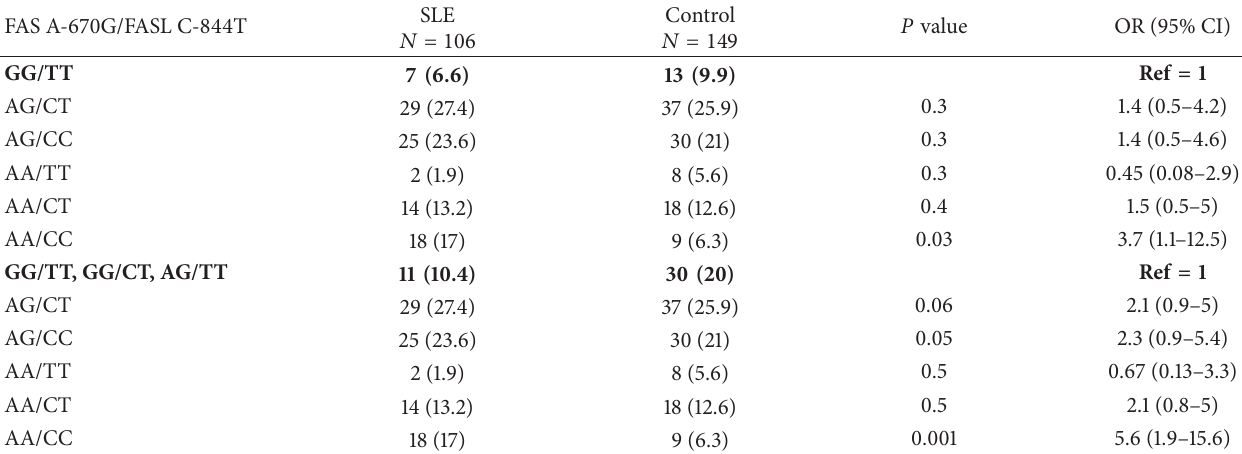
Table 4: Synergic effect of FAS A-670G and FAS ligand C-844T polymorphisms in SLE patients and